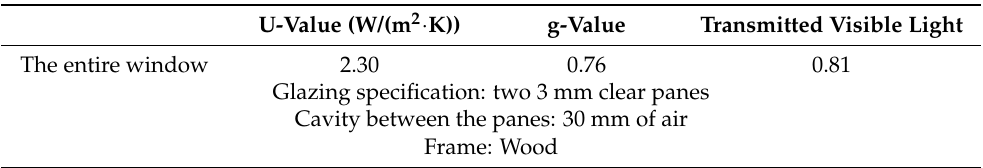
Table 3. The entire window without low-E film; technical data measured in a field test in 2018 by Mattsson et al.